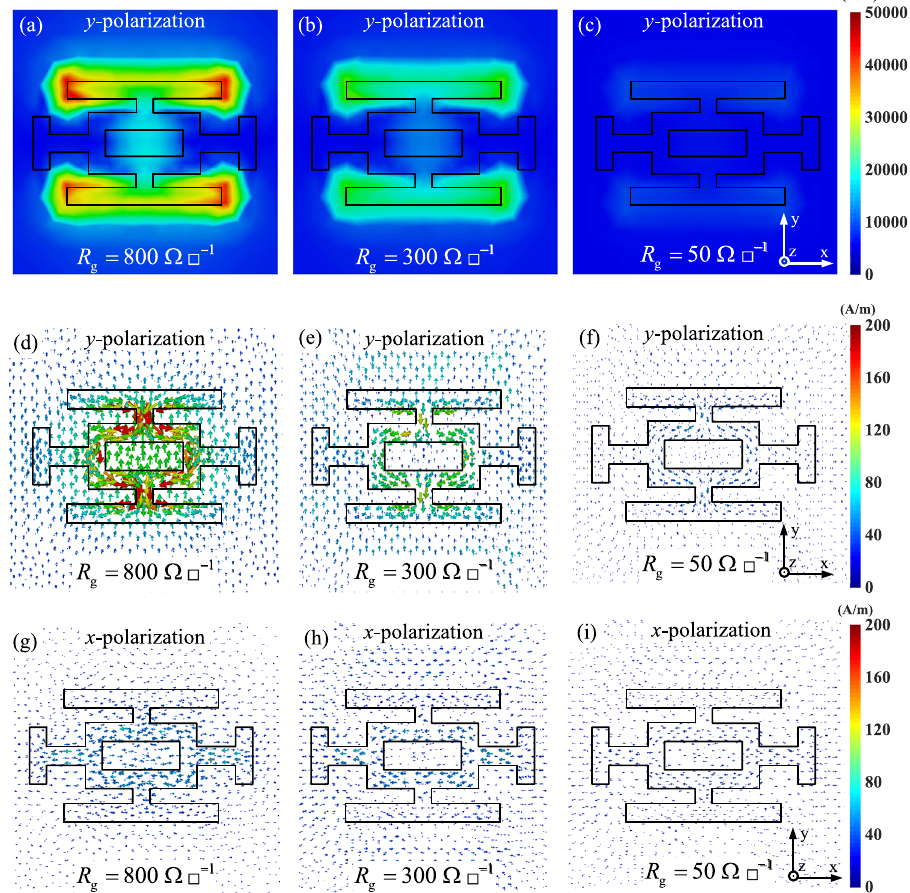
Fig. 5 Electric fi elds and induced currents in graphene-based meta-device. Simulated electric fi elds ( a – c ) and induced surface-current distributions ( d – f ) of the designed meta-device under y -polarized incidence with different sheet resistances of 800, 300, and 50 Ω □ − 1 . Induced surface-current distributions under x -polarized incidence with different sheet resistances of g 800 Ω □ − 1 , h 300 Ω □ − 1 , and i 50 Ω □ − 1